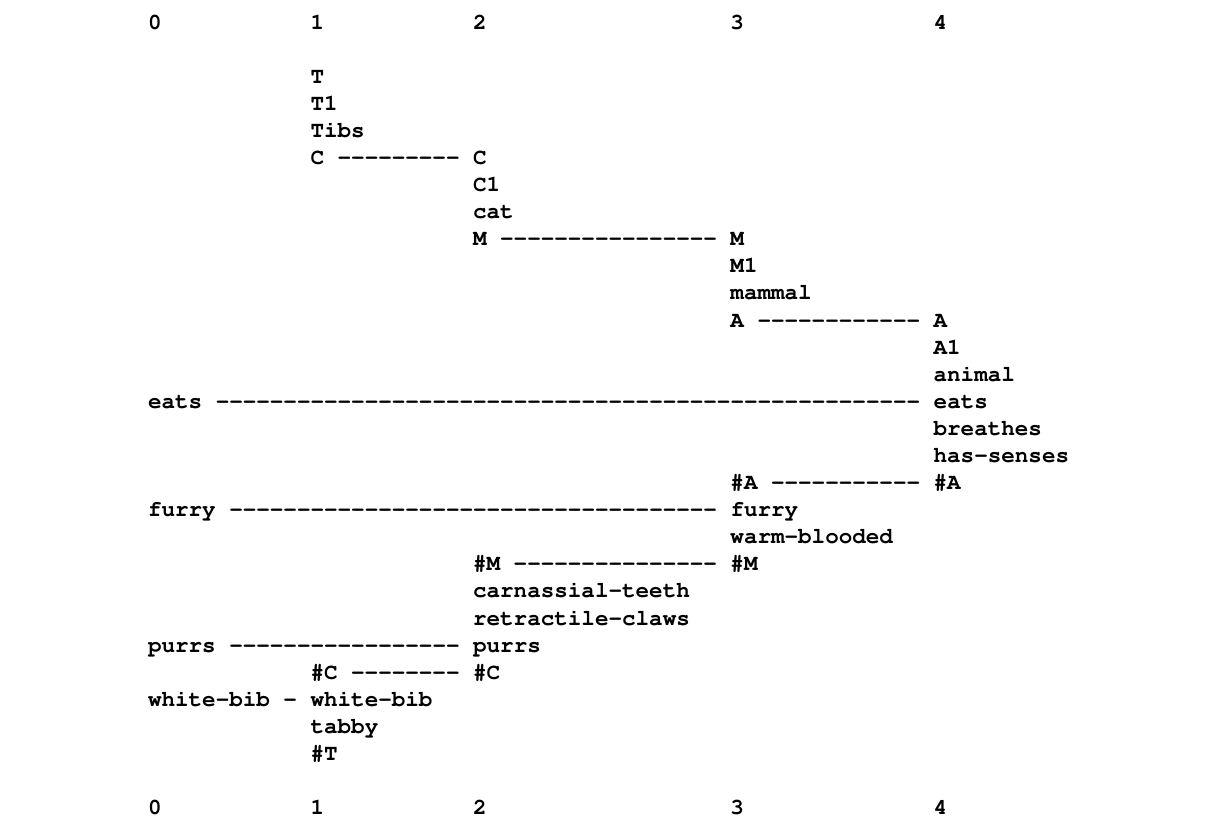
Frontiers in Psychology |